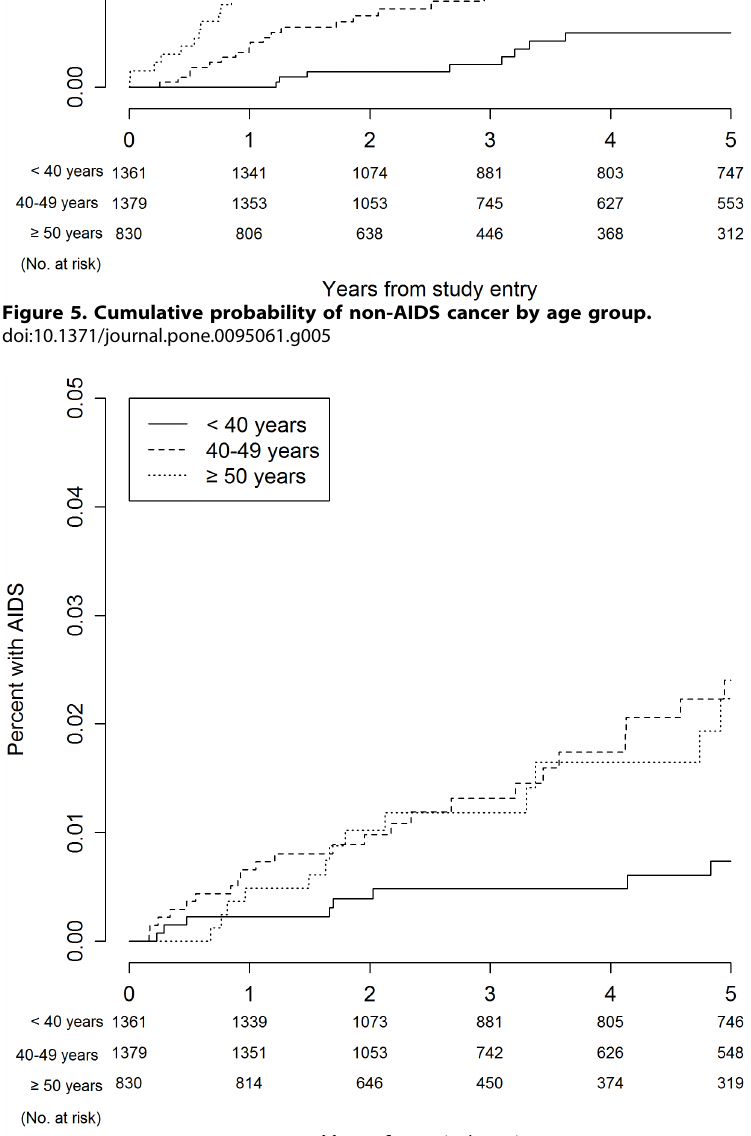
Figure 6. Cumulative probability of AIDS by age group.